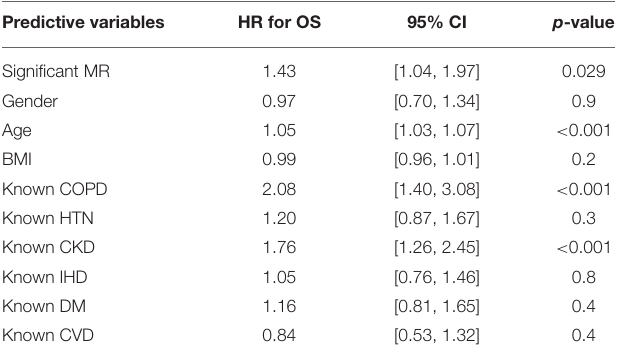
TABLE 6 | Multivariable Cox-regression analysis of significant MR for overall survival at 24